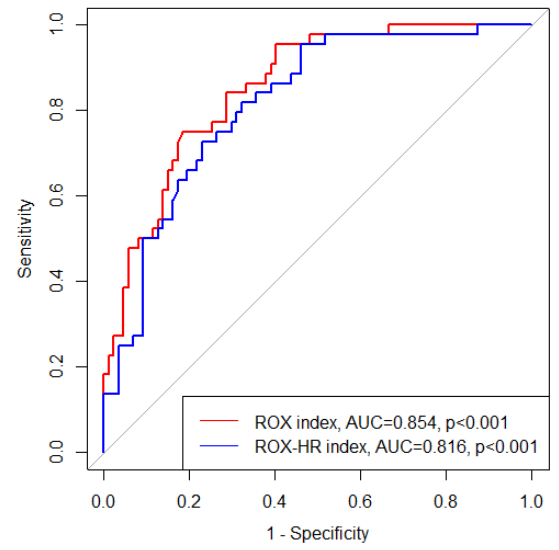
Figure 2. Receiver operating characteristic curve of the ROX index and ROX-HR index for mechanical ventilator use within 24 h. Abbreviations: ROX = respiratory rate oxygenation, AUC = area under curve.